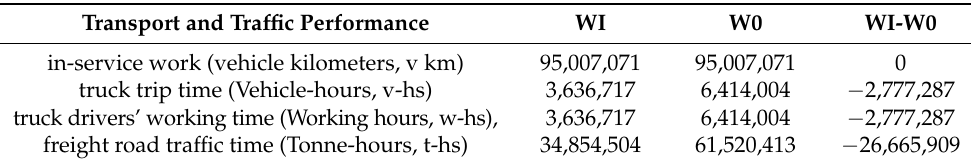
Table 5. Transport and traffic performance effects induced by the reconstruction of the urban-port road system.